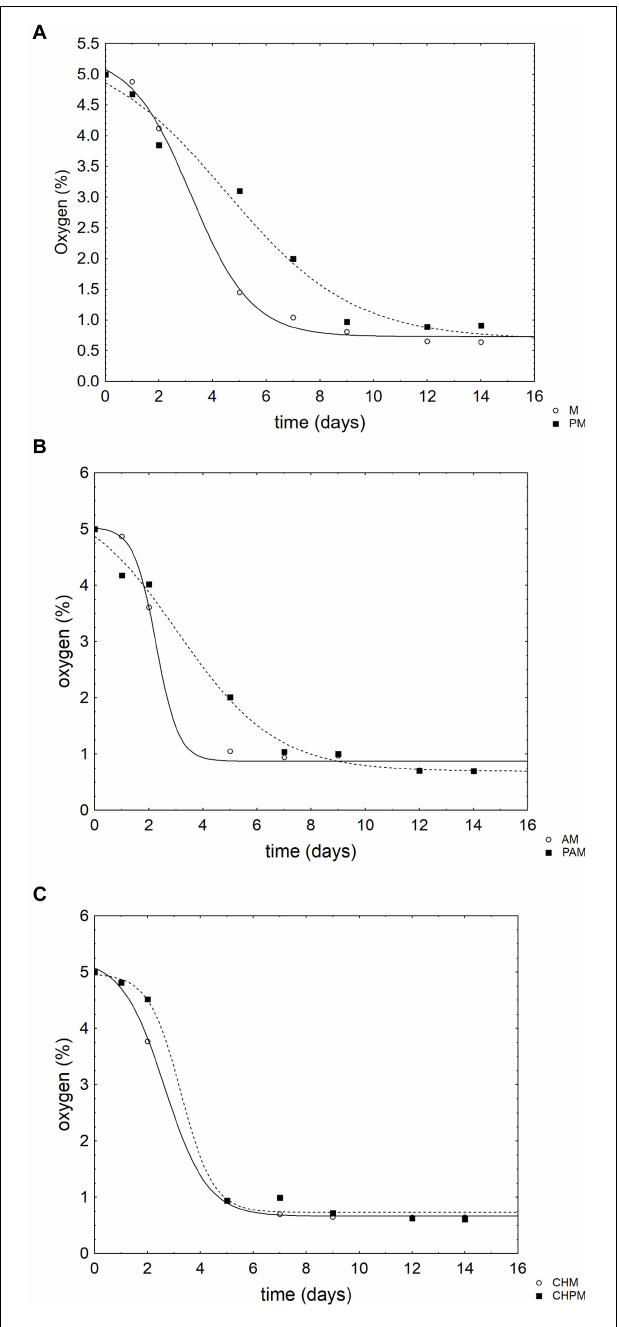
FIGURE 2 | Evolution of oxygen (v/v) in the head space of the samples of apple pieces packed in the modified atmosphere. The points represent the mean of two replicates. The lines represent the best fit through a negative Gompertz equation. For the acronyms of samples see Materials and Methods. (A) Apple pieces; (B) Apple pieces with alginate; (C) Apple pieces with